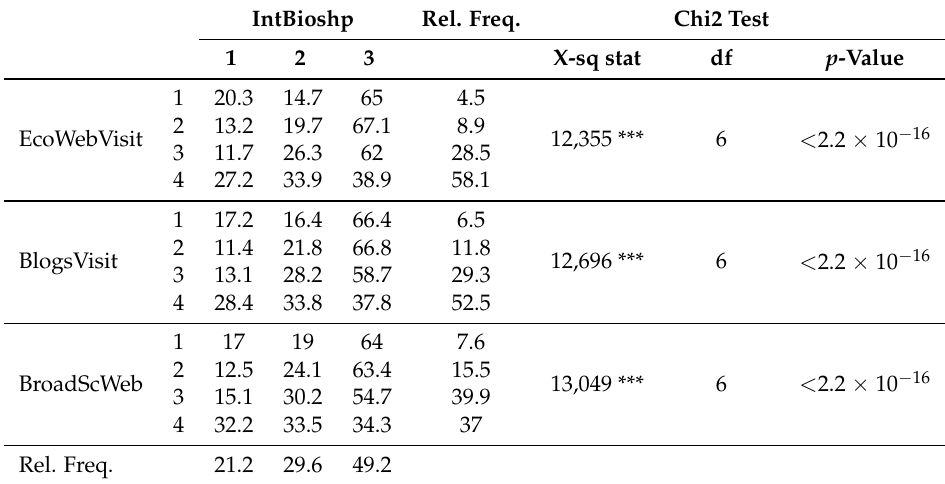
Table A2. Chi-square test results with conditional and relative frequency distributions in % for “IntBioshp”. IntBioshp Rel. Freq. Chi2